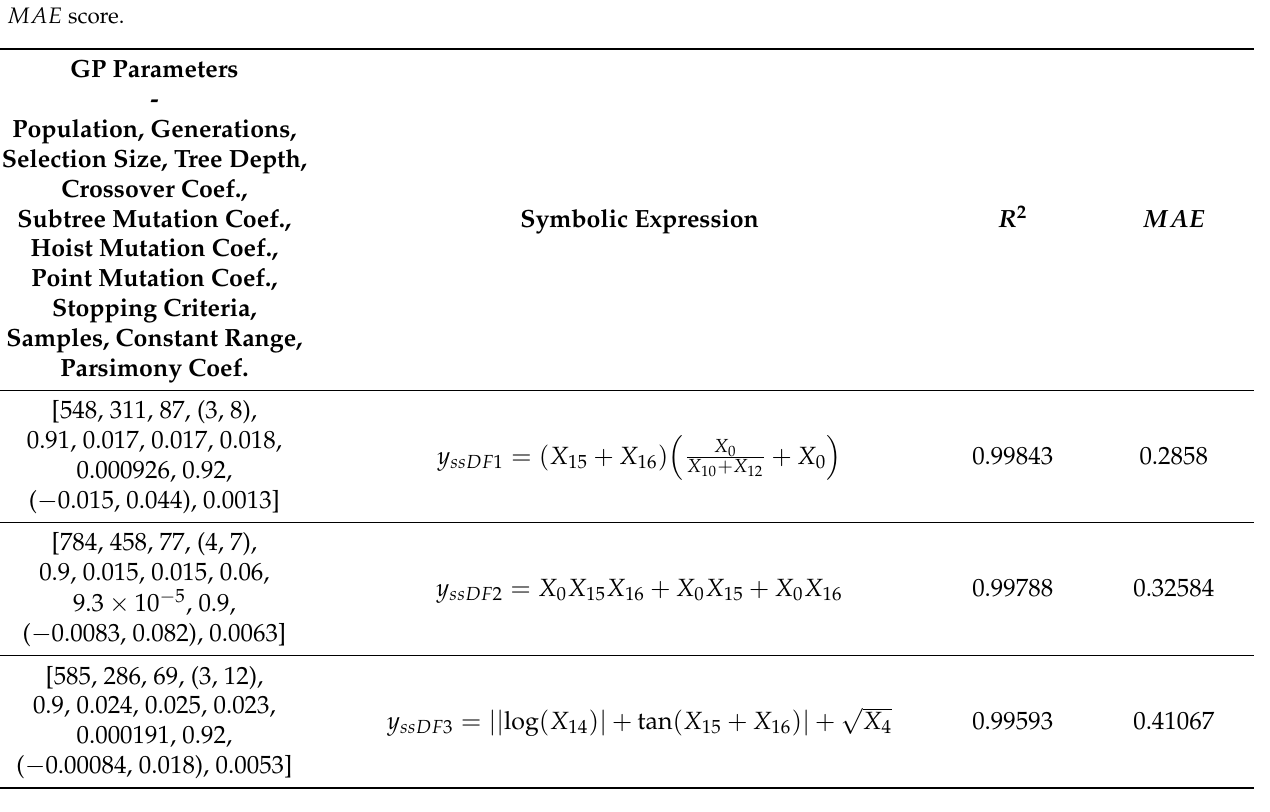
Table 7. Three best symbolic expressions for ship speed estimation without decay state coefficients with corresponding R 2 and MAE